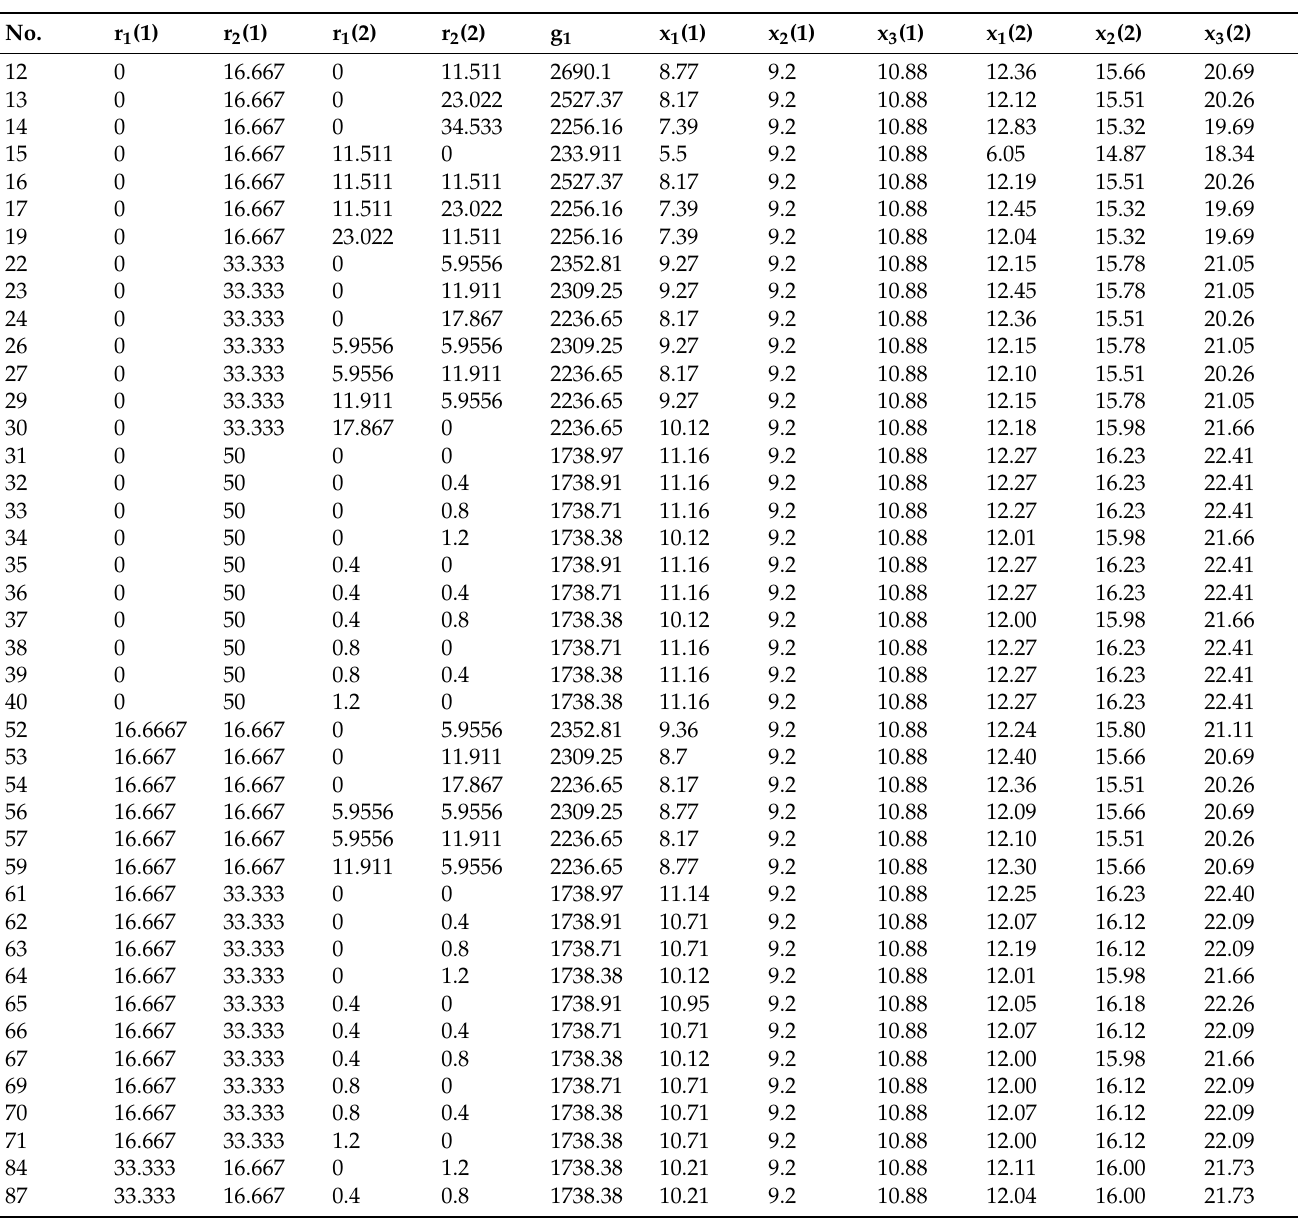
Table A2. Strategies of the first influence agent under fixed strategies of the Principal and the